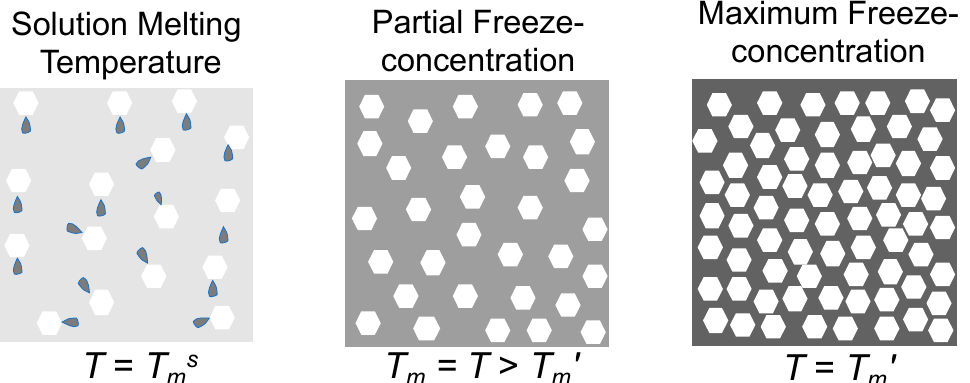
Figure 1. Schematic presentation of ice formation as affected by temperature, T. The equilibrium melting temperature for an unfrozen solution occurs at T ms . Equilibrium quantity of ice occurs at T m during partial freeze concentration and maximum freeze concentration occurs at T m (cid:48)